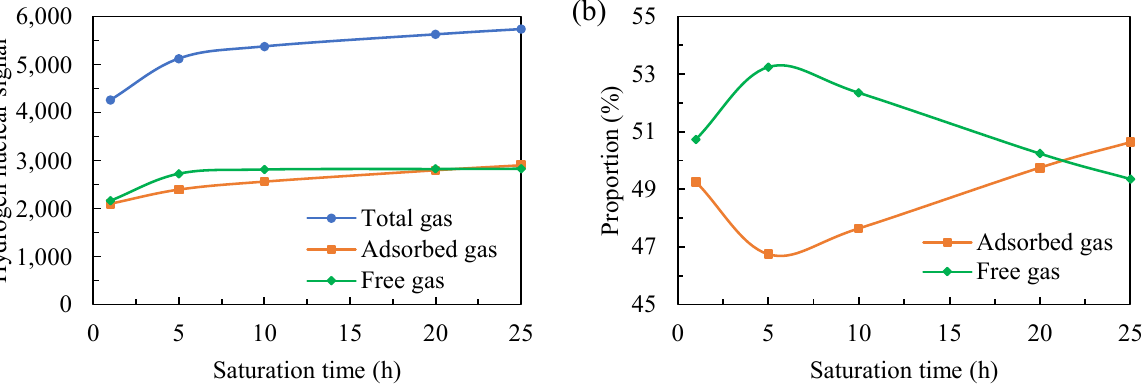
Figure 6. The trend of ( a ) NMR signal and ( b ) proportion of different methane during saturation. In the early stage of saturation, methane enters the shale pores under the action of pressure gradient and forms adsorbed gas and free gas. With the increase in saturation time, the continuous adsorption of methane makes the proportion of adsorbed gas in shale gradually increase, and the concentration gradient becomes the major driving force for shale-saturated methane.